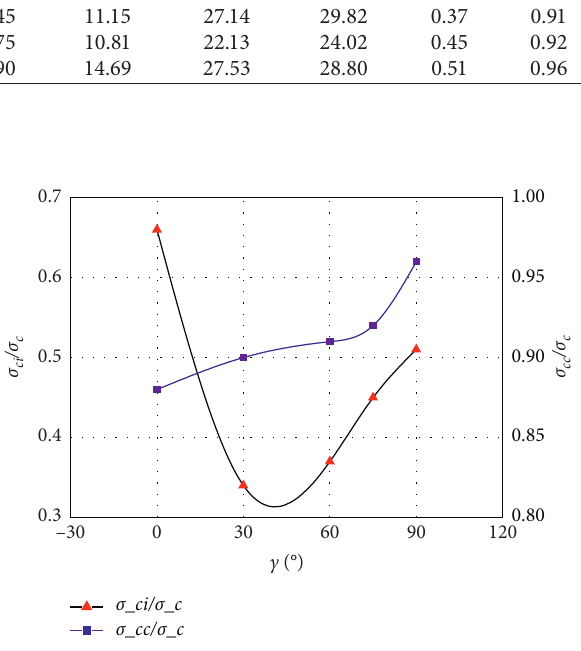
Figure 15: The angle between main and minor flaws ( c ) versus crack initiation and coalescence stress ( ( σ